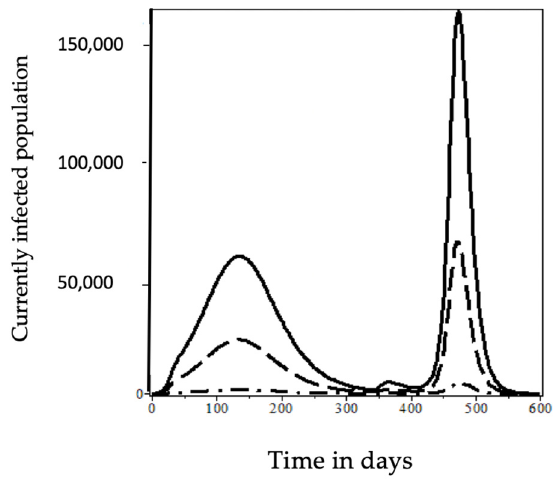
Figure 11. Model prediction of current active cases without vaccination: continuous line Y ( t ) , dashed